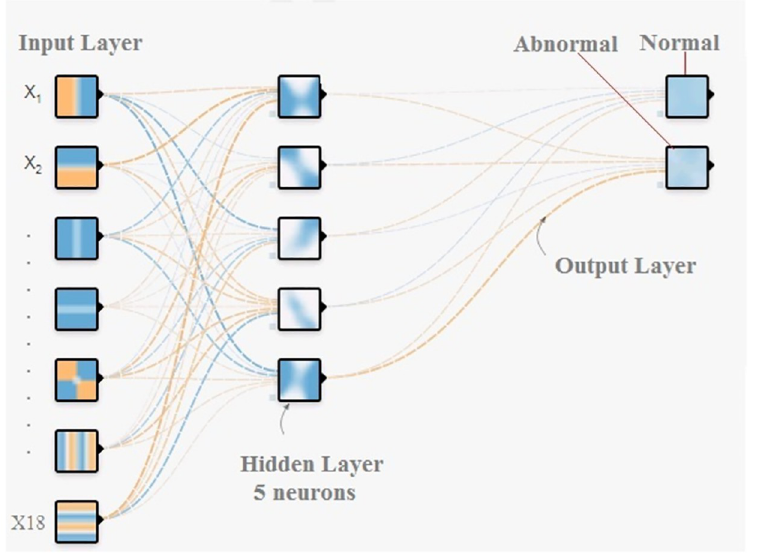
Fig 6. DNN basic structure.